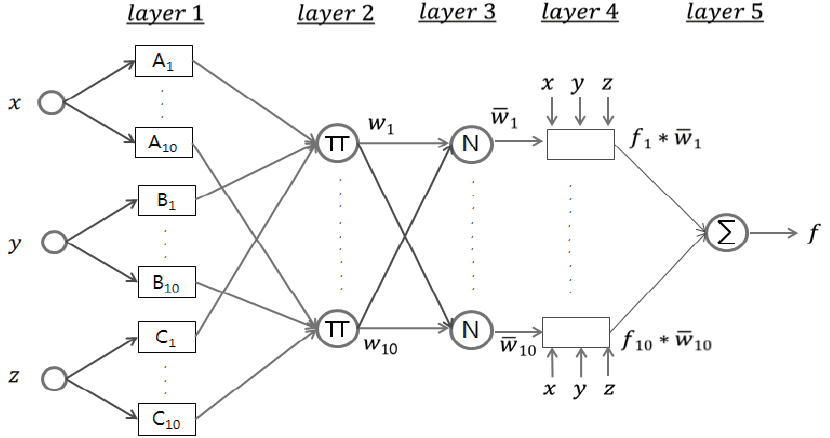
Figure 9. ANFIS structure for density